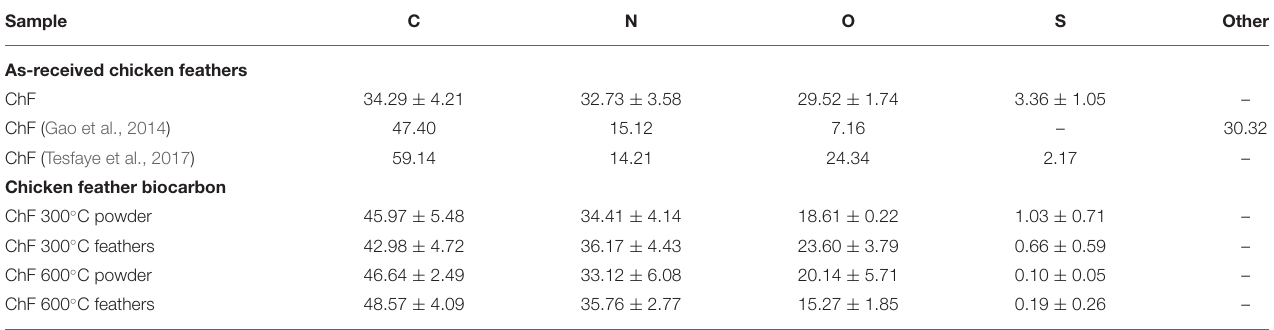
TABLE 4 | EDS data for ChF and ChF biocarbon samples.